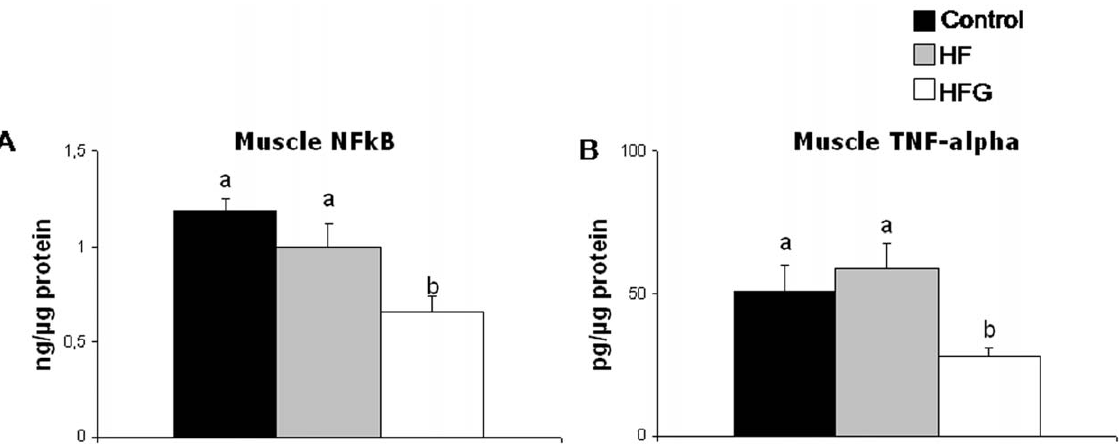
Figure 1. Acylated ghrelin during HF diet lowers gastrocnemius muscle proinflammatory molecules. Effects of one-month high-fat feeding without (HF) or with (HFG) 4-day acylated ghrelin treatment on gastrocnemius muscle levels of nuclear p65 NFkB subunit (a) and TNF-alpha protein (b). Different letters denote statistically significant differences (P , 0.05 ANOVA and post-hoc test). doi:10.1371/journal.pone.0026224.g001 PLoS ONE |